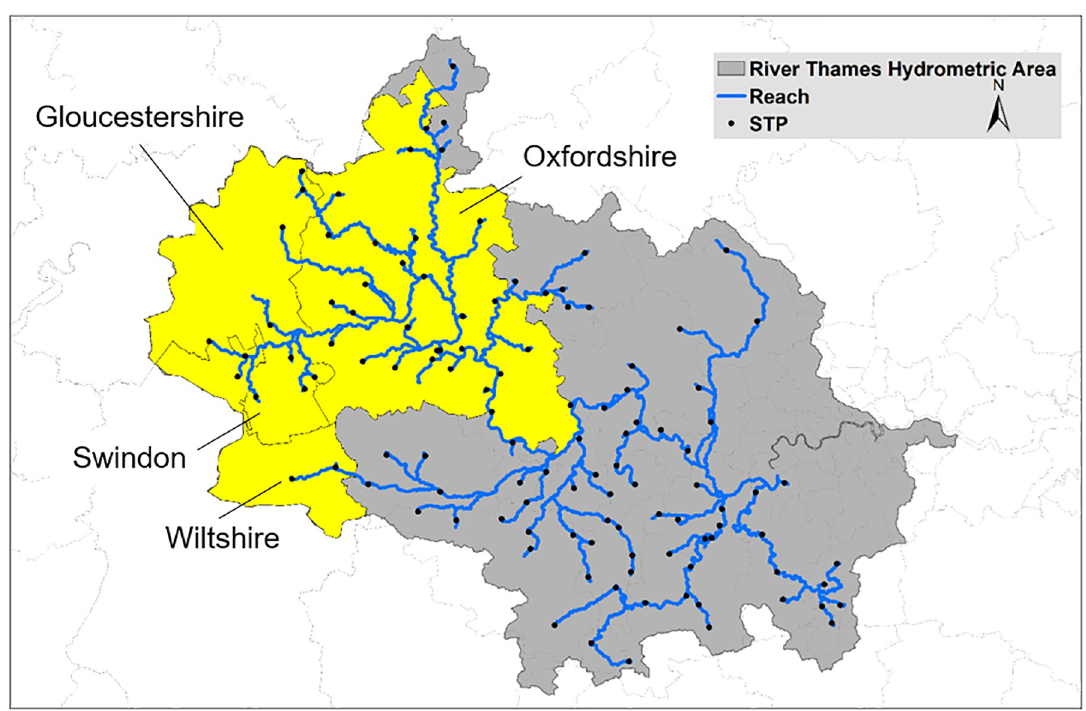
Fig 2. Hydrometric area of Thames Region with the four CCGs in the upper Thames. Catchment denoted in yellow.